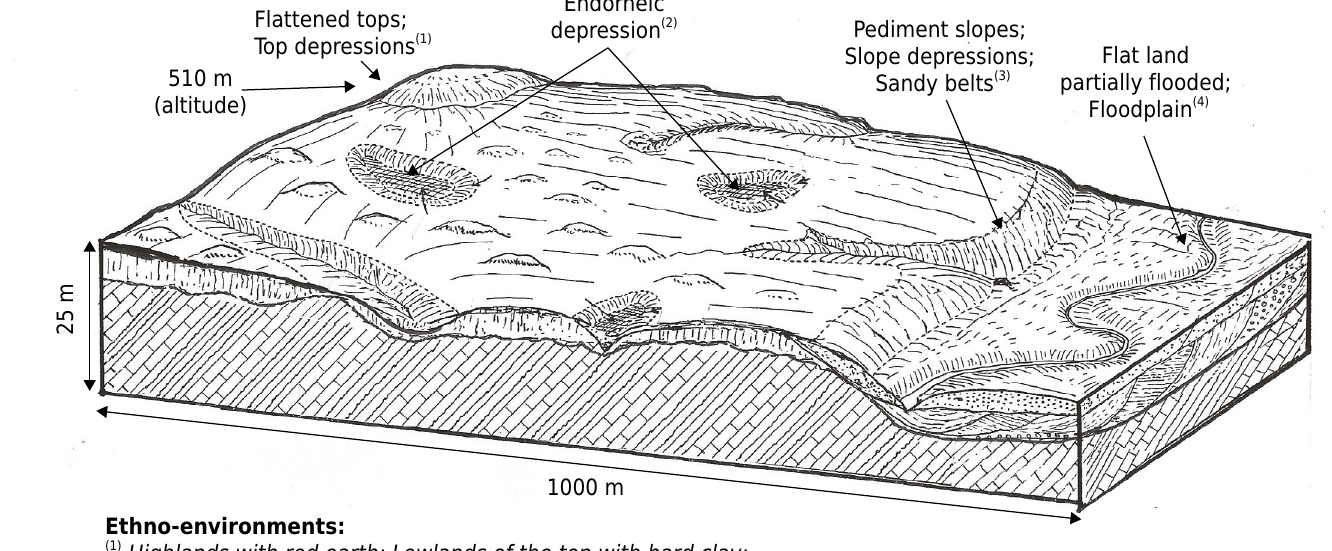
Figure 2. Block-diagram of the Malhada Grande Quilombola Territory (Catuti, MG, Brazil) showing the general landscape developed on alternating slates and limestone of the Bambuí Group (Late Precambrian) covered by Quaternary colluvial (hills and tablelands) and alluvial sediments (floodplain). The Termite Mounds ( Murundus ) are found on the top